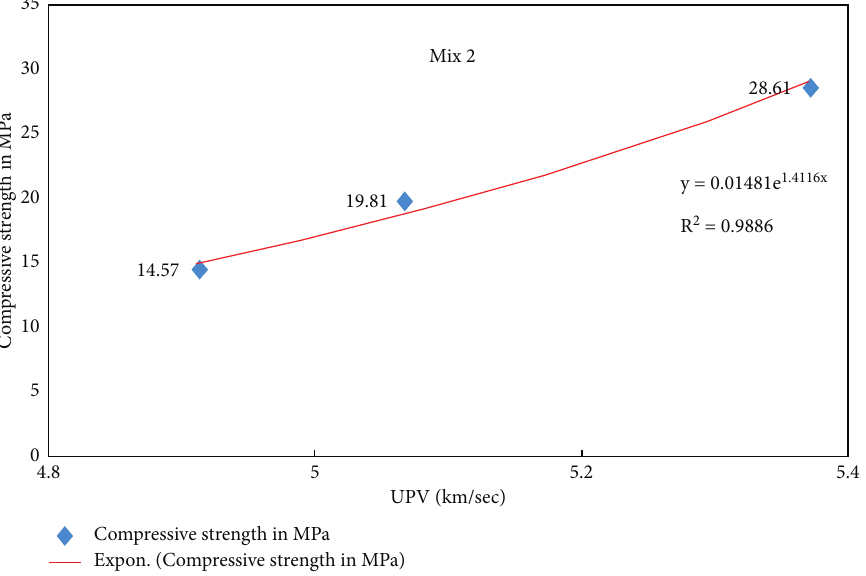
Figure 6: Relation between compressive strength and UPV for Mix